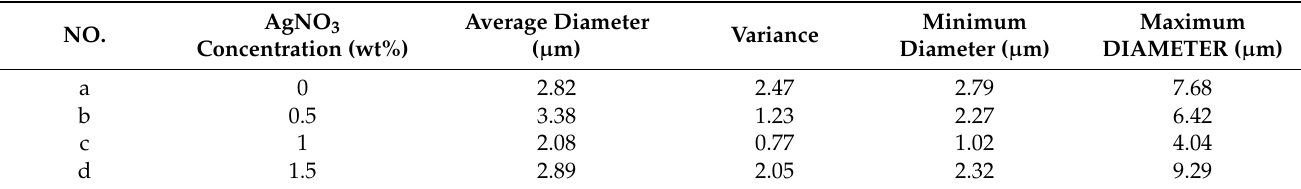
Table 1. Effect of nanofiber diameter with different addition of AgNO 3